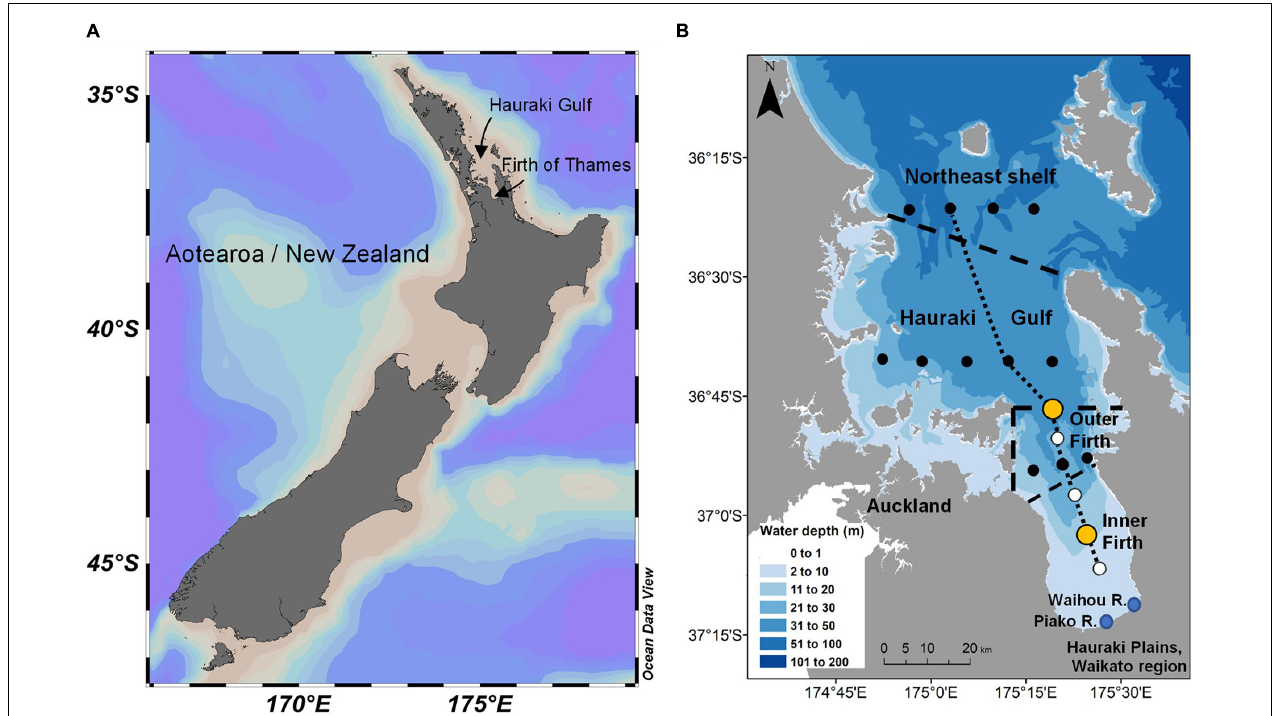
FIGURE 1 | (A) Aotearoa/New Zealand showing locations of Hauraki Gulf and adjoining Firth of Thames. (B) Firth of Thames (“Firth”), Hauraki Gulf and northeast shelf. Large orange circles mark the outer and inner Firth biophysical mooring sites. Black dotted sites were used for mass-balance modelling of Firth, Hauraki Gulf and northeast shelf regions, delineated by heavy dashed lines (Zeldis and Swaney, 2018). All sites were used for CTD-rosette sampling of water quality, carbonate system and fluorometer calibrations. The small dashed line delineates the inner and outer Firth regions used in Figure 10 and Tables 1 , 2 . The dotted line marks the transect plotted in Figure 7 . Also labelled are Auckland city and major river mouths (Waihou and Piako rivers) entering the Firth from the Hauraki Plains in the Waikato